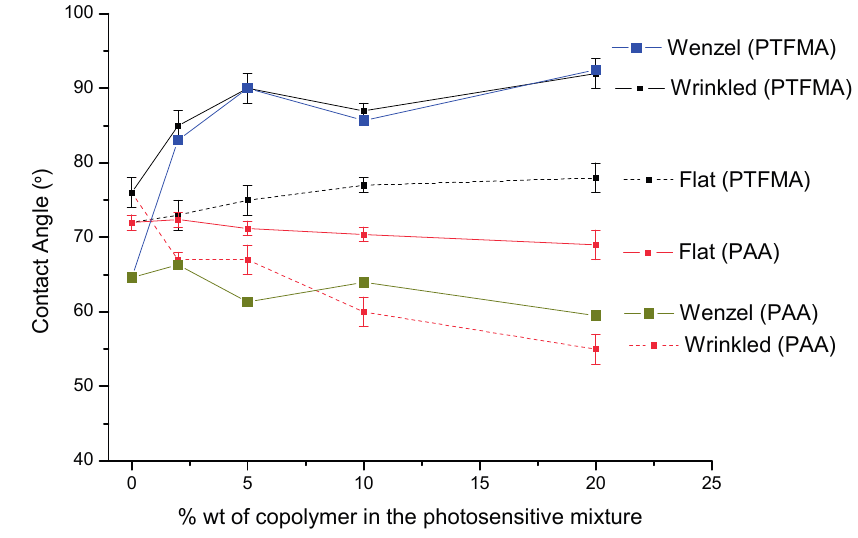
Figure 4. Variation of the contact angle as a function of the wt% of functional copolymer incorporated within the photosensitive mixture. Whereas PAA refers to the copolymer P(MMA- co -AA) introduced, PTFMA refers to the P(TFMA- co -MMA). Flat refers to planar surfaces, wrinkled to the surfaces with wrinkled interfaces and Wenzel to the contact angle values calculated using the Wenzel